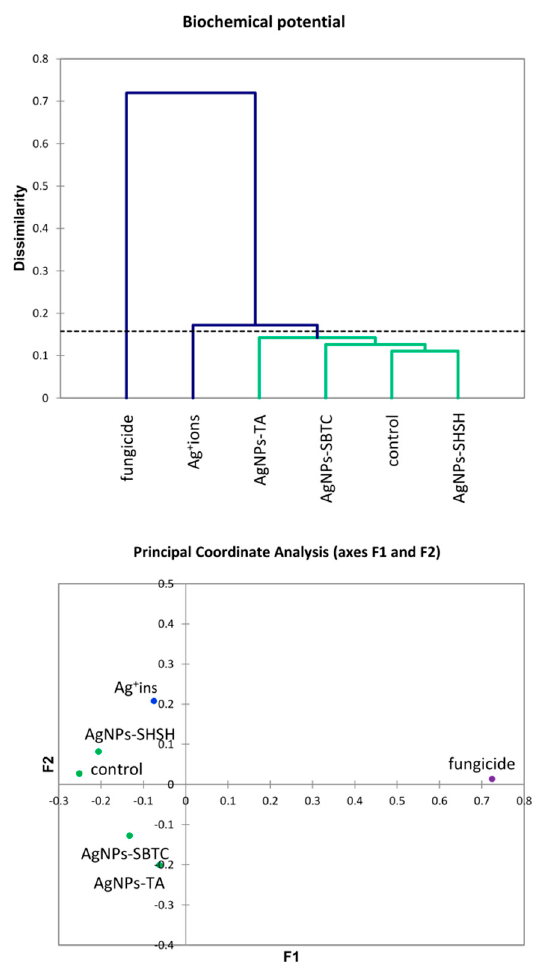
Figure 7. Agglomerative Hierarchical Clustering analysis (Bray and Curtis method) of soil bacteria biochemical activities in the control and treated soils ( top ) and the relationship between bacterial biochemical activities depending on the treatments according to PCoA ( bottom ).